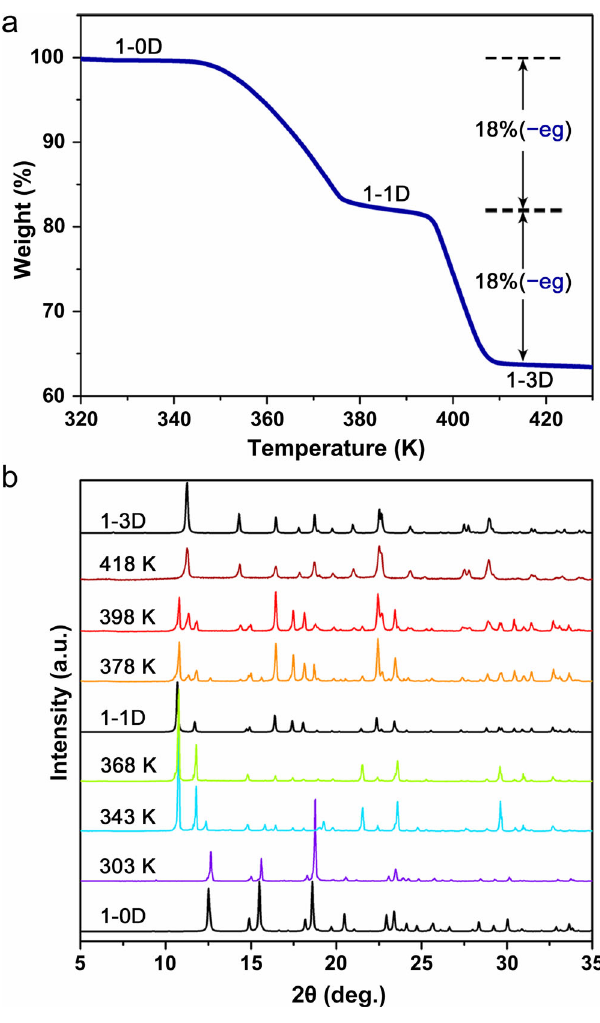
Fig. 2 Crystal transformation monitored by TG and PXRD